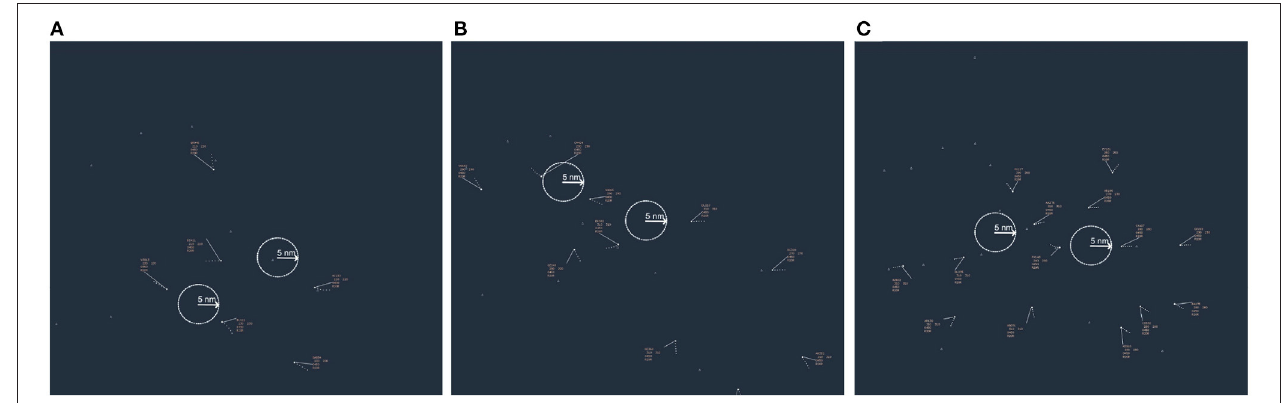
FIGURE 5 | First block of three simulation trials showing three levels of air traffic density (ATD): (A) low (six aircraft), (B) medium (10 aircraft), and (C) high (14 aircraft). White circles, each with a radius of 5.0 nm, delineate the boundaries of the conflict zones. Such circles were not shown during simulation. Through a Latin square design, the pairwise combinations of conflict sites recurred in two different, non-overlapping sequences across the three ATD conditions over the next two blocks of trials (three trials each). The initial arrangement of aircraft in each subsequent ATD condition differed from the arrangement of aircraft shown within the first trial block and varied from each